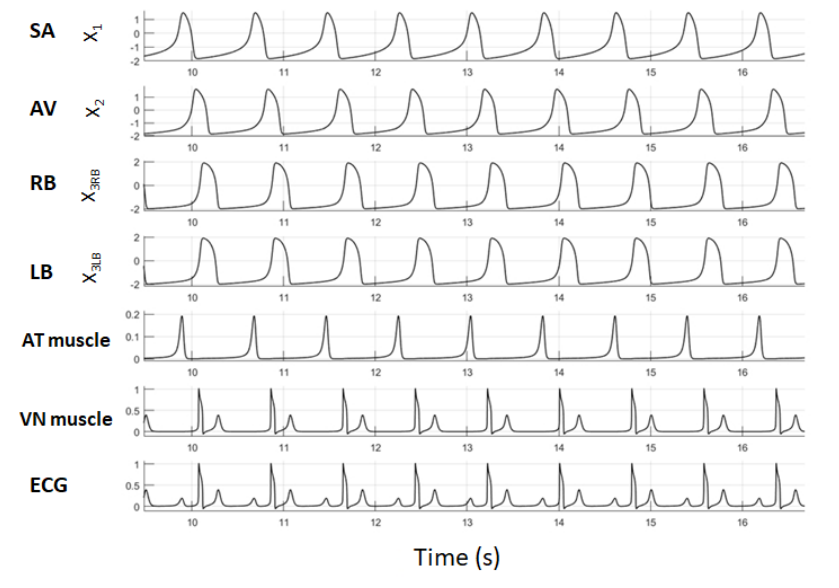
Figure 4. Action potentials, muscles response and ECG signal in non-pathological (70